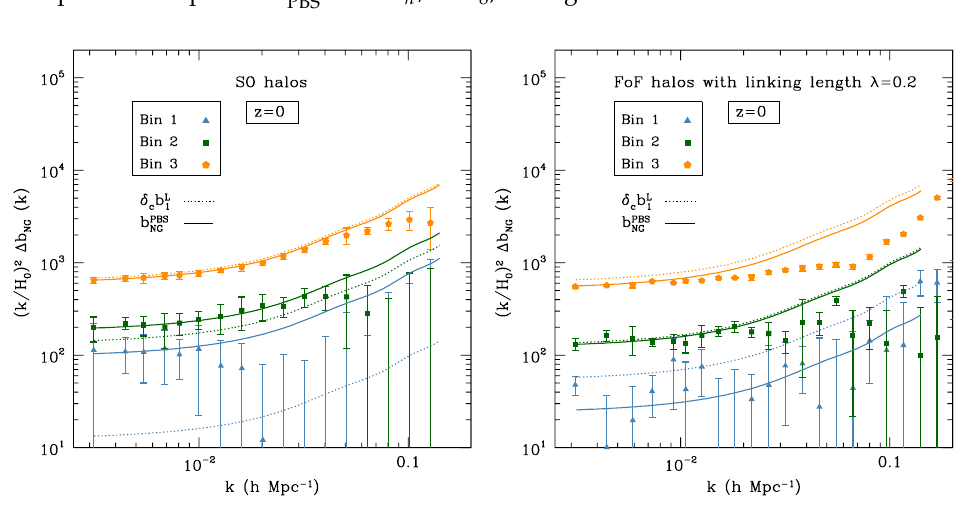
Figure 3. Non-Gaussian bias for the three different halo mass bins, rescaled by ( k / H 0 ) 2 , as a function of wavenumber k at redshift z = 0. Left panel shows results from a SO halo finder algorithm (AHF code [331]) and right panel for a Friends-of-Friends algorithm with linking length λ = 0.2. Credits to